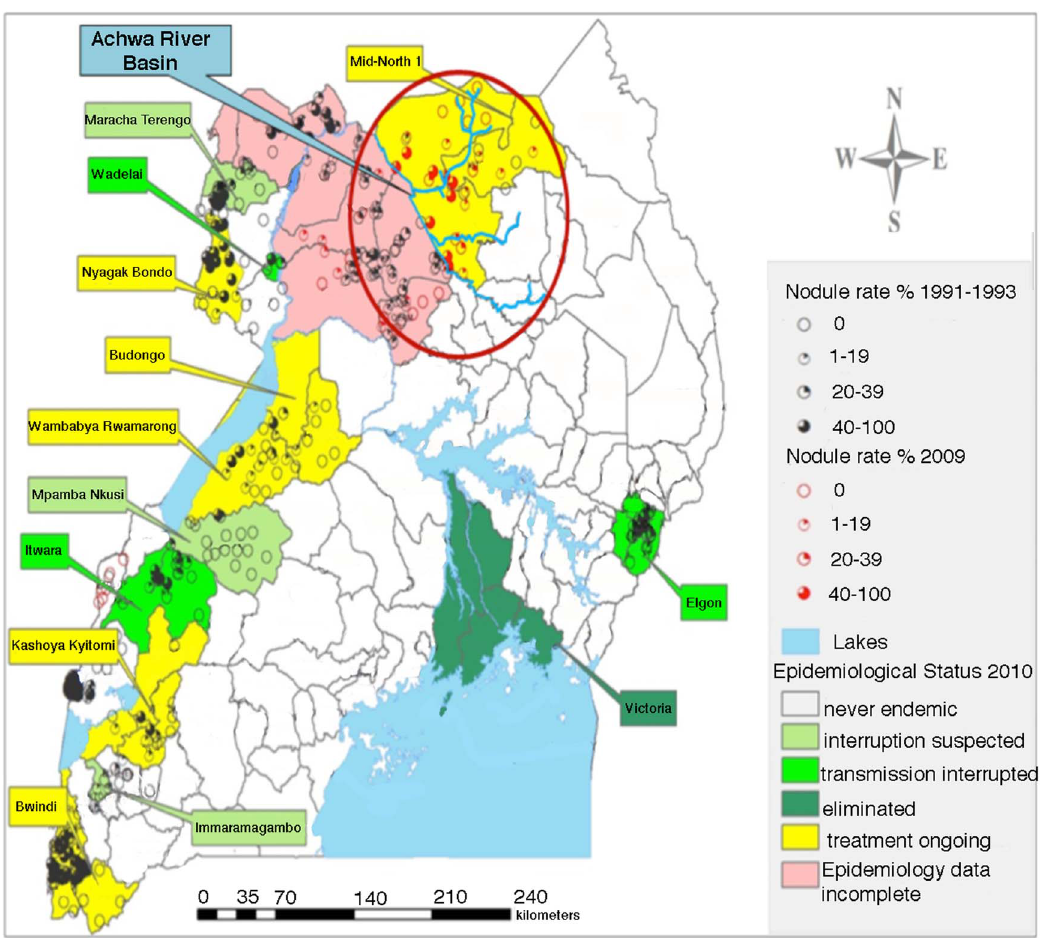
Figure 2. Northern Uganda study site. The map presents data collected by the Ugandan Ministry of Health on the prevalence of onchocerciasis in Uganda. The red circle indicates the location of the Achwa River basin examined in this project.